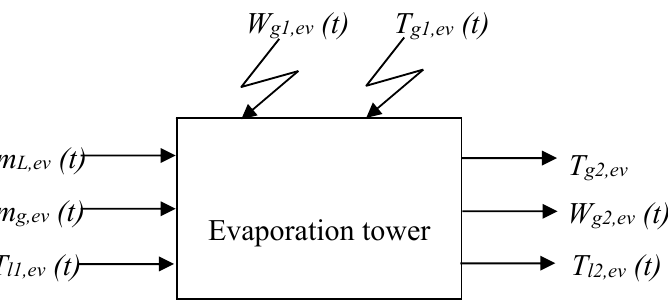
Figure 7. The input/output block diagram of the evaporation tower. Figure 7. The input / output block diagram of the evaporation